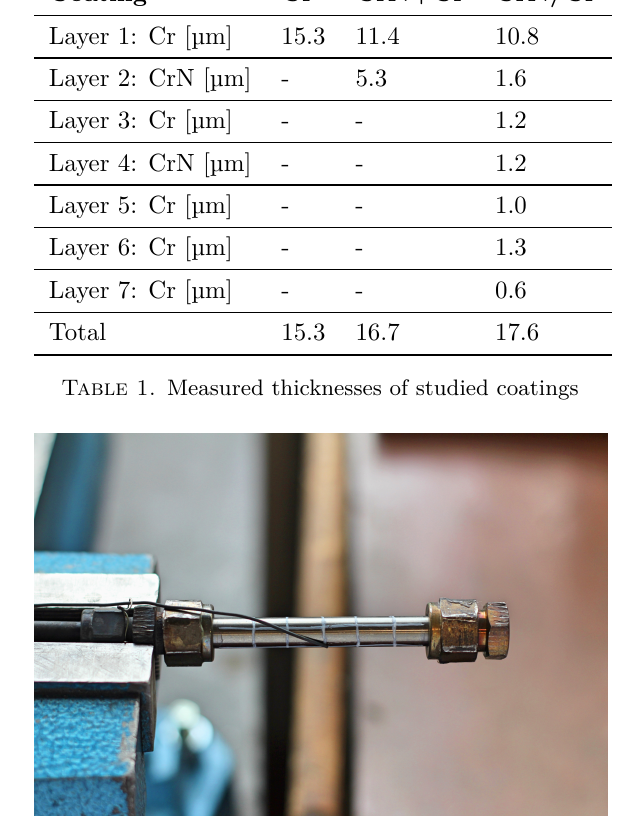
Figure 1. Burst-test specimen before exposition in argon